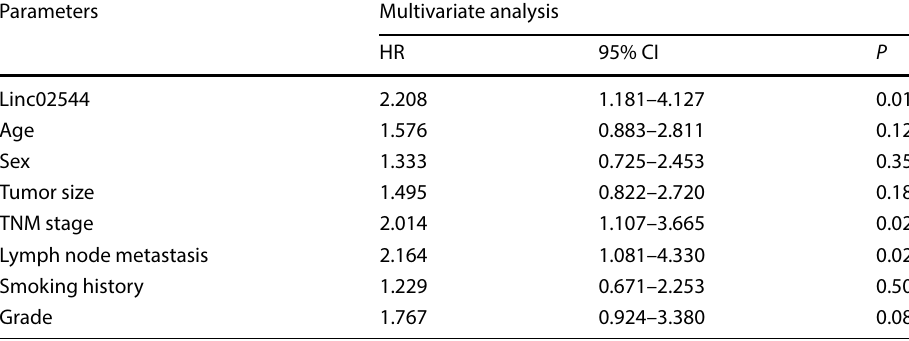
Table 2 Multivariate Cox analysis of clinical characteristics in relation to overall